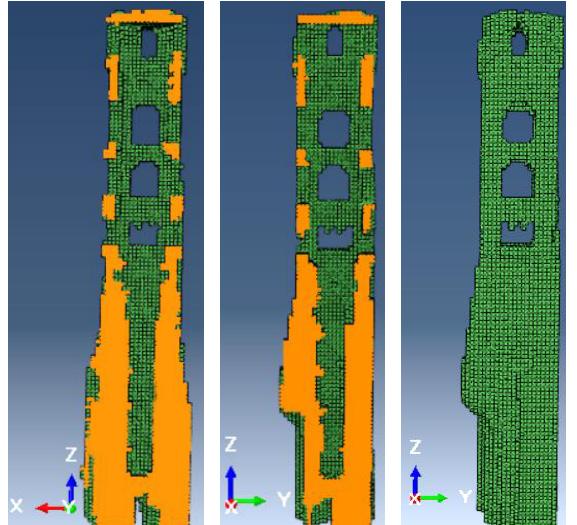
Figure 10. From left, cross section along X and Y, and final voxel model. All the internal parts are correctly defined.